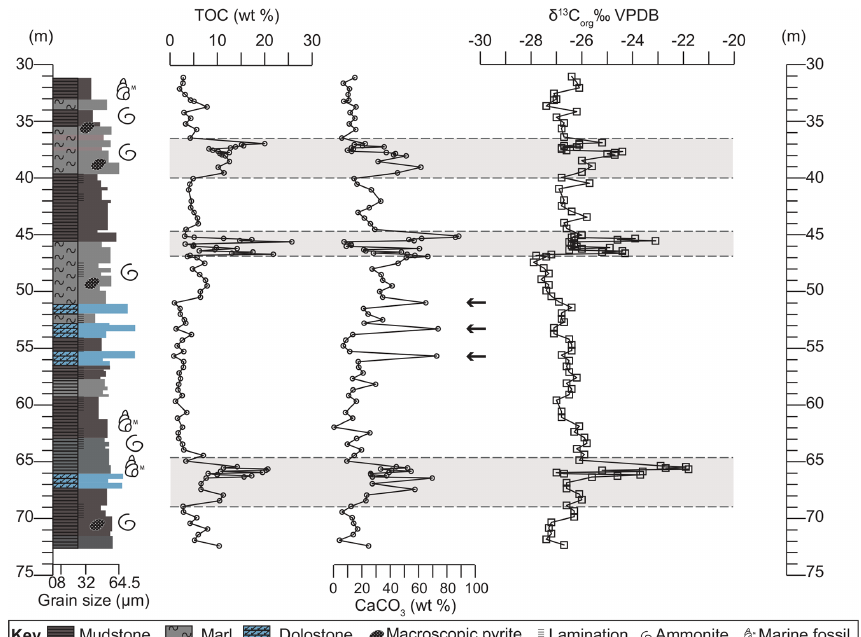
Figure 2. Graphic log showing lithological variation of the studied section. Depth plots of total organic carbon (TOC) contents (wt%), calcium carbonate (CaCO 3 ) contents (wt%), and organic carbon isotope values (‰VPDB). Grey panels depict the higher-variability intervals (HVMIs) defined in this study. Black horizontal arrows indicate samples with obvious diagenetic